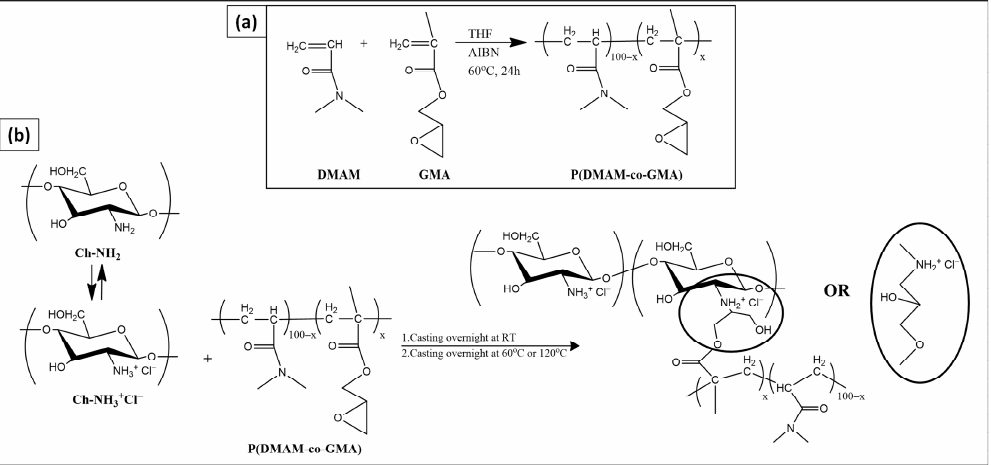
Figure 1. Schematic representation of the chemical synthesis of ( a ) P(DMAM-co-GMA) copolymer and ( b ) cross-linked chitosan-based membranes.